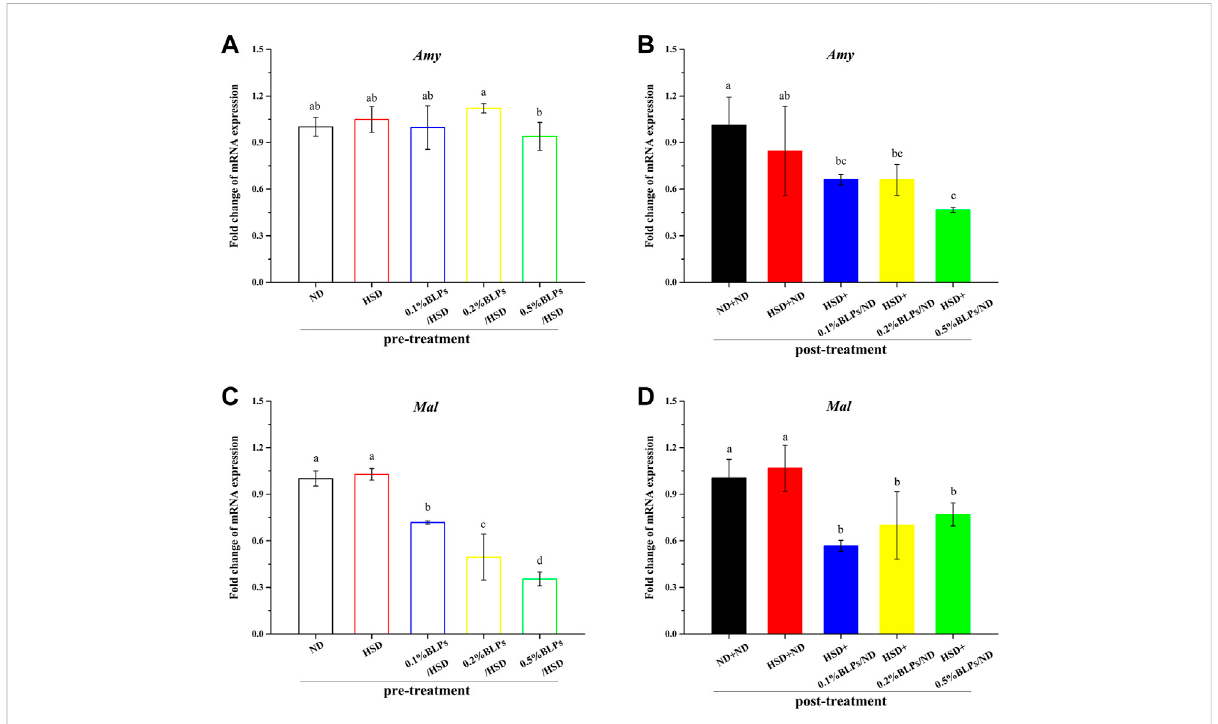
FIGURE 5 mRNA expression of Amy gene (A,B) and Mal-5b gene (C,D) of those fl ies fed on media containing BLPs at different concentrations in pre- treatment and post-treatment, respectively. Values with different letters (A – D) represent signi fi cant differences among the groups ( p <